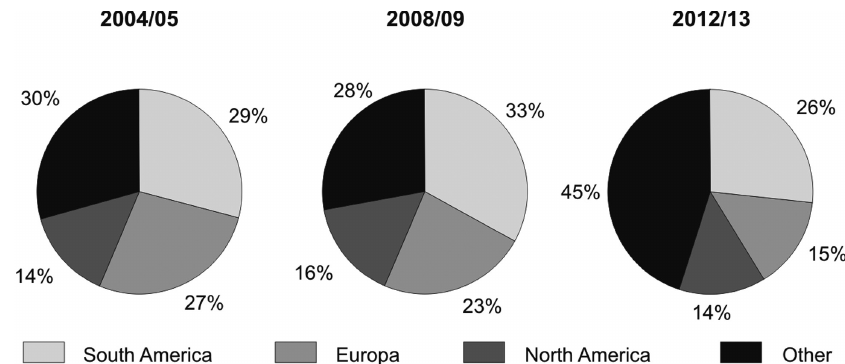
Fig. 6. The structure of origin of tourists visiting Aconcagua by continents (represented by their main countries) in seasons 2004/2005, 2008/2009 and